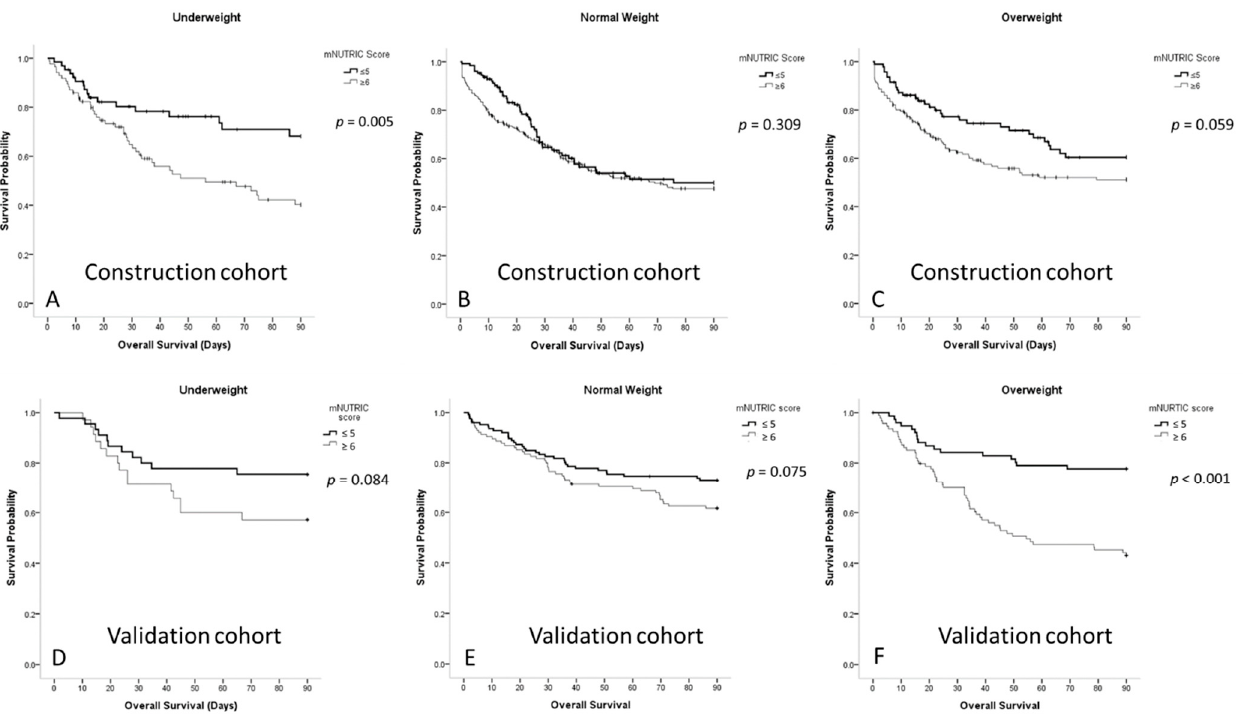
Figure 2. ( A ) Survival curves for underweight patients with sepsis in the medical intensive care unit according to the mNUTRIC scores in the construction cohort; ( B ) survival curves for normal-weight patients with sepsis in the medical intensive care unit according to the mNUTRIC scores in the construction cohort; ( C ) survival curves for overweight patients with sepsis in the medical intensive care unit according to the mNUTRIC scores in the construction cohort; ( D ) survival curves for underweight patients with sepsis in the medical intensive care unit according to the mNUTRIC scores in the validation cohort; ( E ) survival curves for normal-weight patients with sepsis in the medical intensive care unit according to the mNUTRIC scores in the validation cohort; ( F ) survival curves for overweight patients with sepsis in the medical intensive care unit according to the mNUTRIC scores in the validation